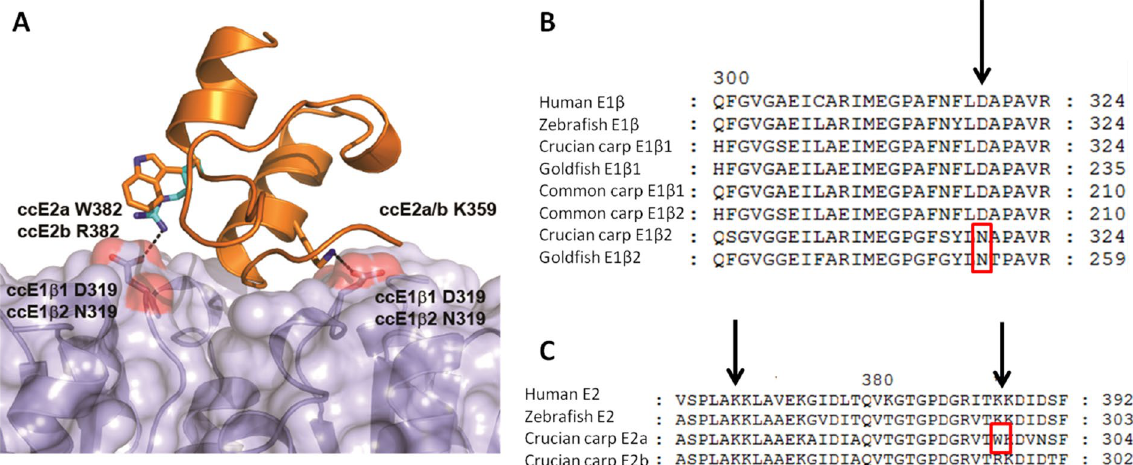
Figure 3. E1–E2 contact sites. (A) Structural model of the interaction sites between the E1 β 1 dimer (blue) and the peripheral subunit binding domain of the E2b monomer in crucian carp (cc) PDHc (orange). The highlighted E1–E2 interaction is critically dependent on the salt bridge forming ccE1 β 1 D319, which is substituted by neutral N in ccE1 β 2 . Whether one or both of the indicated salt bridges between E1 β dimers and E2 monomers are lost depends on which E1 β and E2 paralogs that form the complex, see text for further information. (B) Alignment of amino acids 298–324 of E1 β and (C) amino acids 357–392 of E2 in selected organisms (positional numbering follows the human sequences). Arrows pinpoint E1–E2 contact sites, with substitutions impairing contact